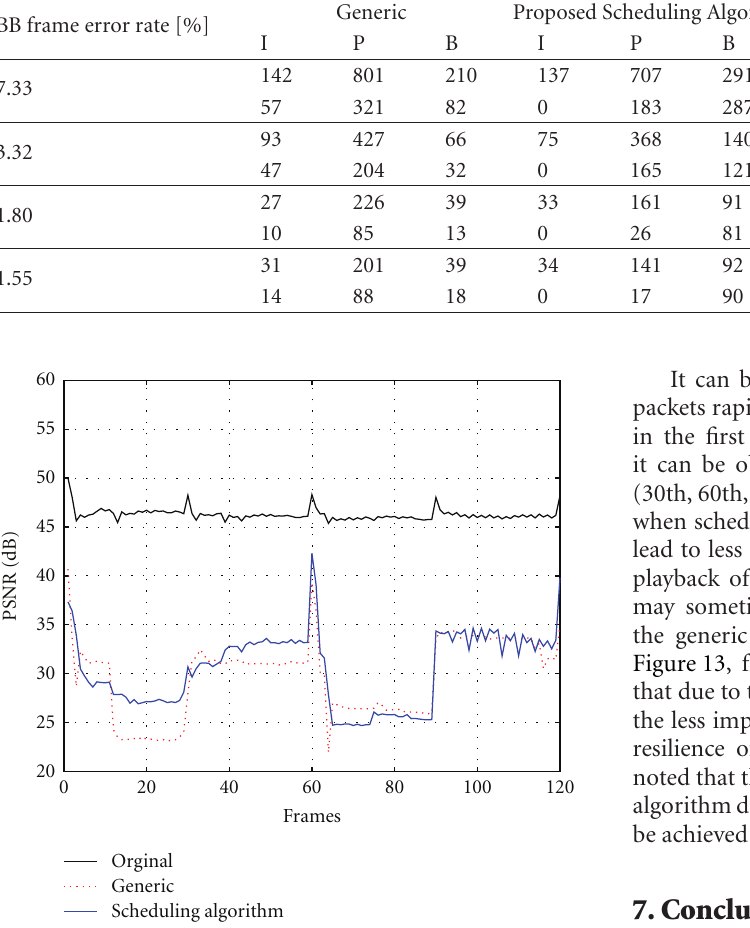
Figure 13: PSNR of crew sequence for the first 120 frames.